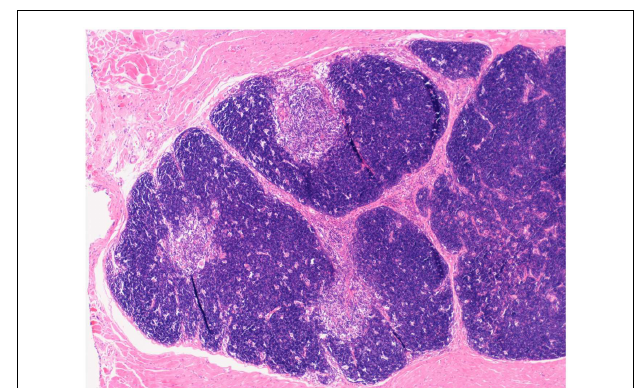
FIGURE 3 | Low-power view of a biopsy of transplanted thymus stained with Hematoxylin and Eosin. Normal looking thymic tissue surrounded by striated muscle.There is good corticomedullary